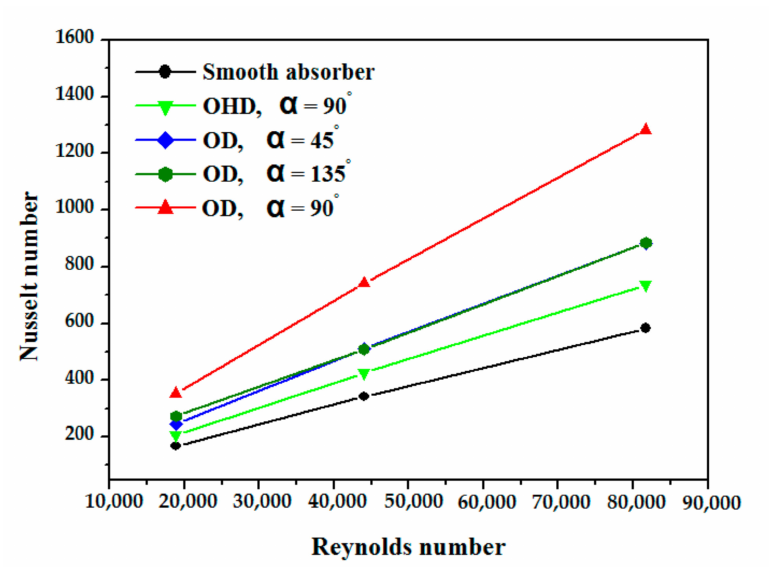
Figure 7. Nussle number with Gnielinski correlation [58].